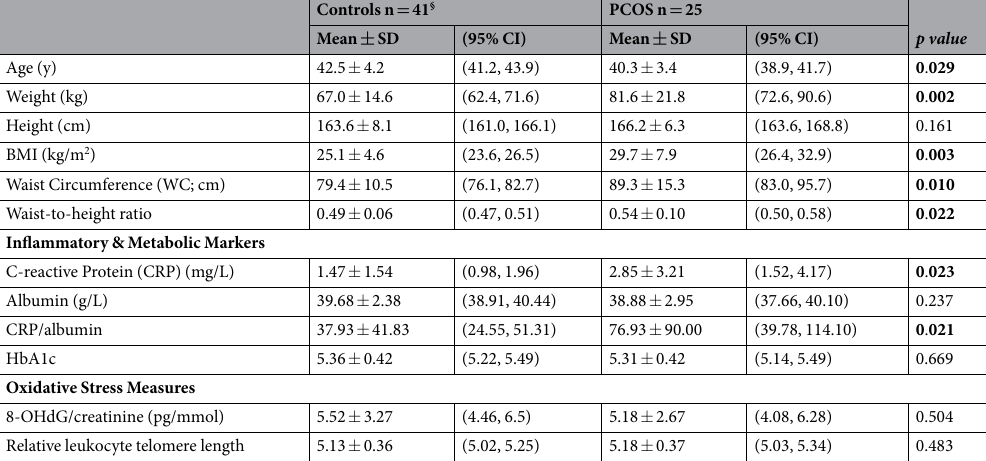
Table 1. Characteristics of premenopausal women with and without polycystic ovary syndrome (PCOS). § One woman was unable to give blood, n = 40 for CRP, albumin and